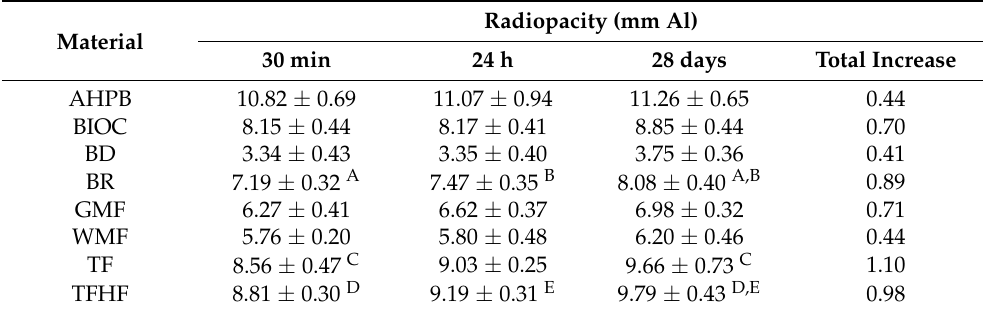
Table 2. Mean values and standard deviations of radiopacity at different time